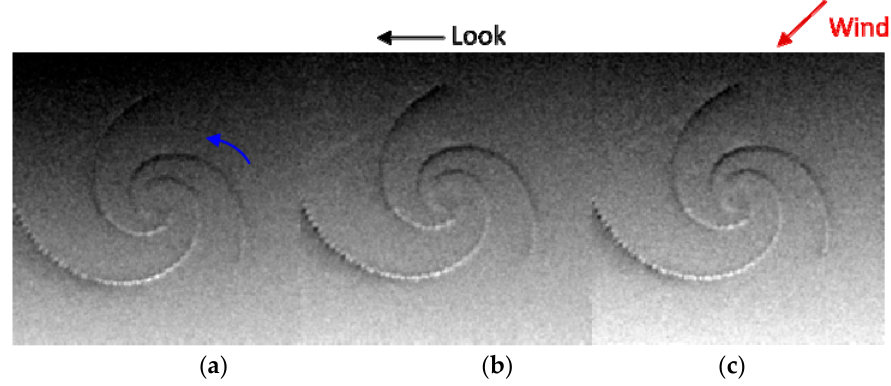
Figure 16. Simulated SAR images under different wind speeds. ( a – c ) correspond to wind speeds of 4 m/s, 7 m/s, and 10 m/s respectively. The red arrow represents the wind direction, the black arrow represents the radar look direction, and the blue arrow indicates the rotation direction of the current field.